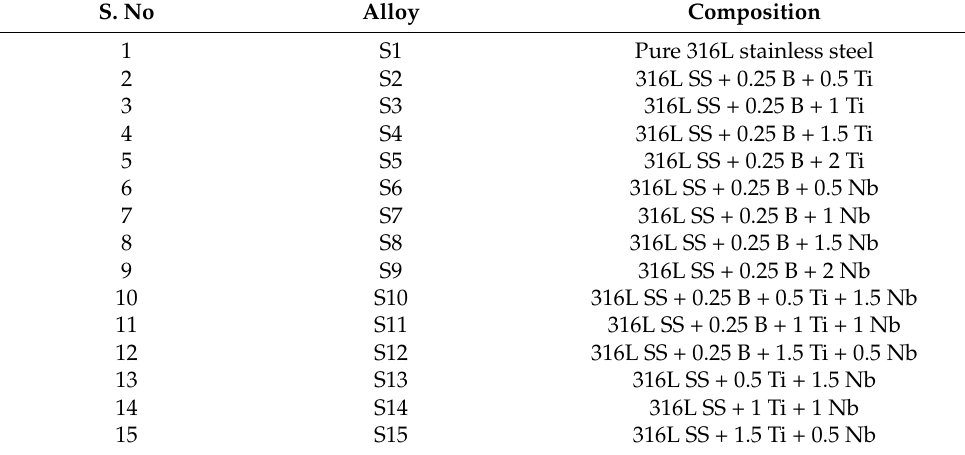
Table 2. Composition of the